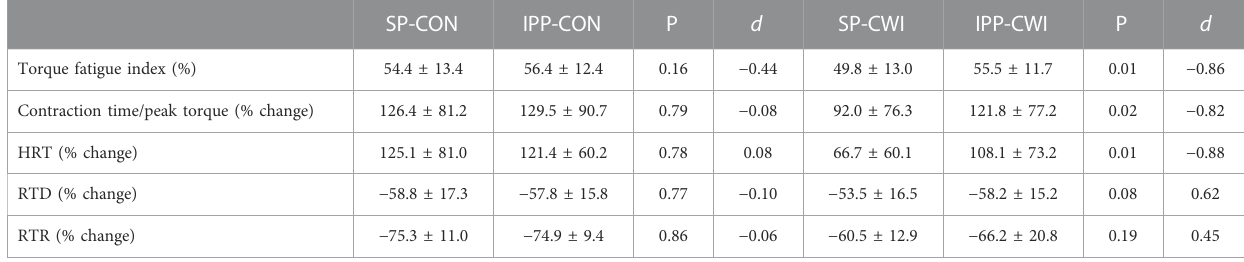
TABLE 2 Torque fatigue index and changes in contractile properties during the fatiguing protocol.